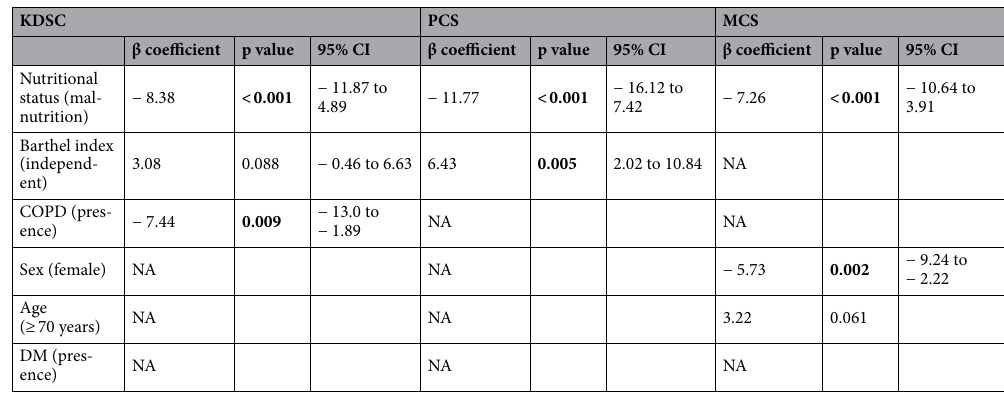
Table 3. Multiple linear regression according to KDSC, PCS, and MCS variables. Significant values are in bold. Data are expressed as mean ± standard deviation for normal data. KDSC Kidney Disease Summary Component, PCS physical component summary, MCS mental component summary, NA not